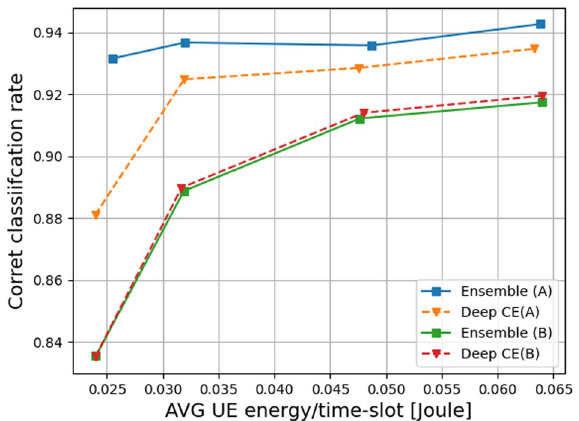
Fig. 12 Accuracy versus UE’s energy, for different learning architectures and wireless channel scenarios